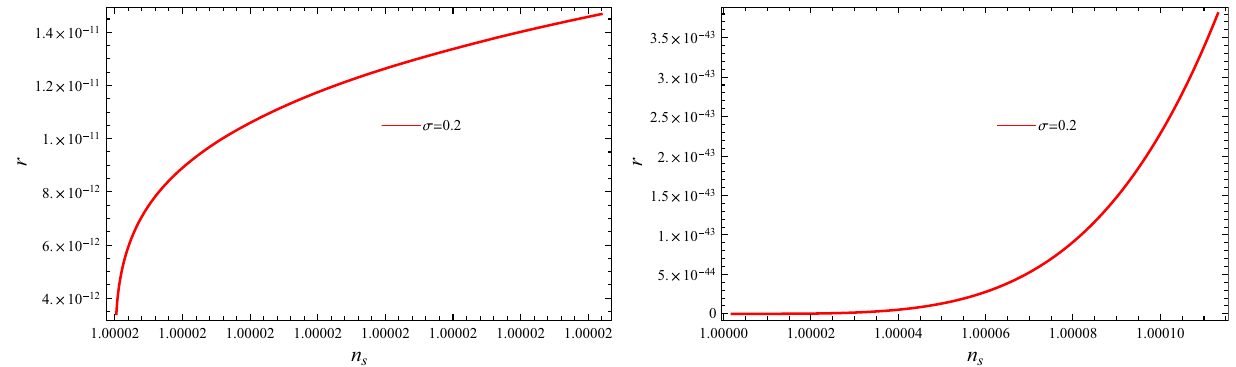
Fig. 2 Plot of r versus n s for GCG model in weak (left panel) and strong (right panel) dissipative regimes for positive potential with n = − 1